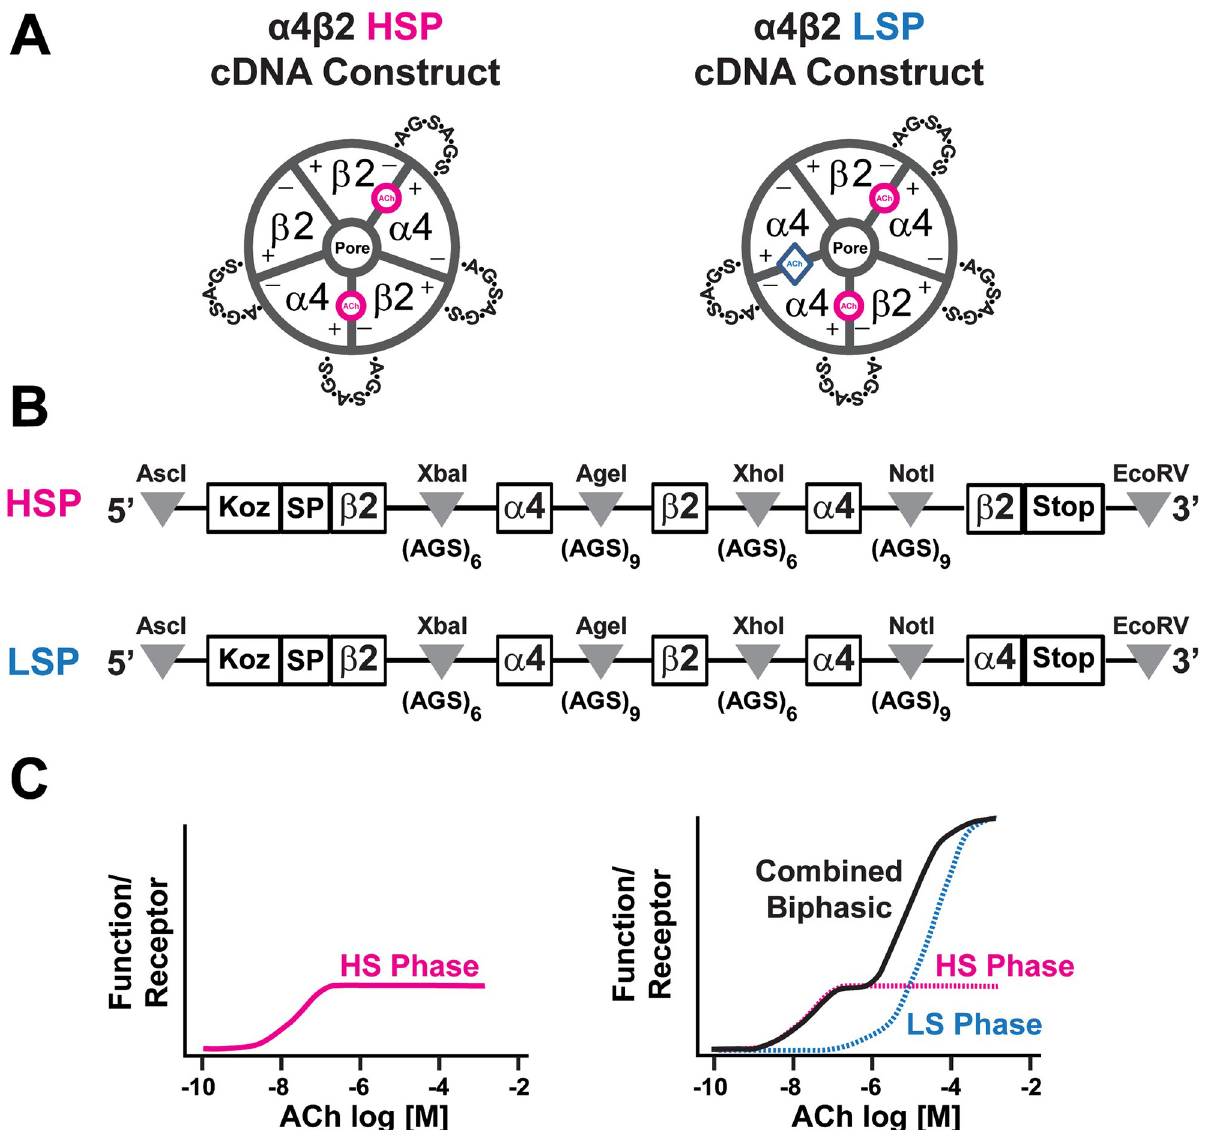
Fig 1. Schematic representations of high-sensitivity ( α 4 β 2) 2 β 2- and low-sensitivity ( α 4 β 2) 2 α 4-nAChR isoforms. A) Configuration of nAChR α 4 and β 2 protein subunits in each of the two isoforms. In this case, fully-concatenated pentameric isoforms are illustrated (HSP and LSP, respectively, with the short A-G-S peptide linkers that are used to enforce subunit associations shown). Note that both isoforms contain two canonical agonist binding sites (magenta circles) at the interfaces between the (+)-face of an α 4 subunit and the (-)-face of a β 2 subunit. The LS-isoform ( α 4 β 2) 2 α 4-nAChR contains an additional agonist binding site (blue diamond) at the interface between the (+)- and (-)-faces of two α 4 subunits. In receptors assembled from unlinked α 4 and β 2 nAChR subunits, mixed populations of the same two isoforms are typically formed. Each isoform exhibits the same ratios and associations of subunits as shown for the corresponding concatenated assembly, but A-G-S linkers are absent. It is also possible to produce essentially-pure populations of HS- or LS-isoform α 4 β 2-nAChR by expressing strongly-biased ratios of unlinked subunits (see methods section for details). B) Illustration (from top to bottom) of cDNA constructs used to express concatenated HSP ( α 4 β 2) 2 β 2- and LSP ( α 4 β 2) 2 α 4-nAChR isoforms. Each construct is flanked with AscI and EcoRV restriction sites (5’ and 3’, respectively; indicated by gray triangles) for subcloning into high expression oocyte vectors. A Kozac sequence and the β 2 signal peptide (SP) were retained only for the 1st position. Flanking each subunit position are unique restriction sites (indicated by gray triangles) used in concatemer design (for example, NotI and EcoRV were used in exchanging nAChR subunits at position 5). The two concatemers differ in composition only at position 5, containing either the β 2 or α 4 subunits in the HSP or LSP constructs, respectively. C) Illustrations of the whole-cell concentration response relationships of each α 4 β 2-nAChR isoform. On the left, high-sensitivity isoform ( α 4 β 2) 2 β 2-nAChR produce a single-phase response (shown in magenta, and resulting from ACh binding to the pair of high- affinity α 4(+)/(-) β 2 agonist binding sites. On the right, low-sensitivity isoform ( α 4 β 2) 2 α 4-nAChR produce two response phases. One, again shown in magenta, is also produced by ACh engagement of the pair of α 4(+)/(-) β 2 agonist binding sites that is conserved across the two isoforms. This exhibits a similar EC 50 value, and results in a similar amount of function per receptor, as is seen for the high-sensitivity isoform. Accordingly, it is named “HS-